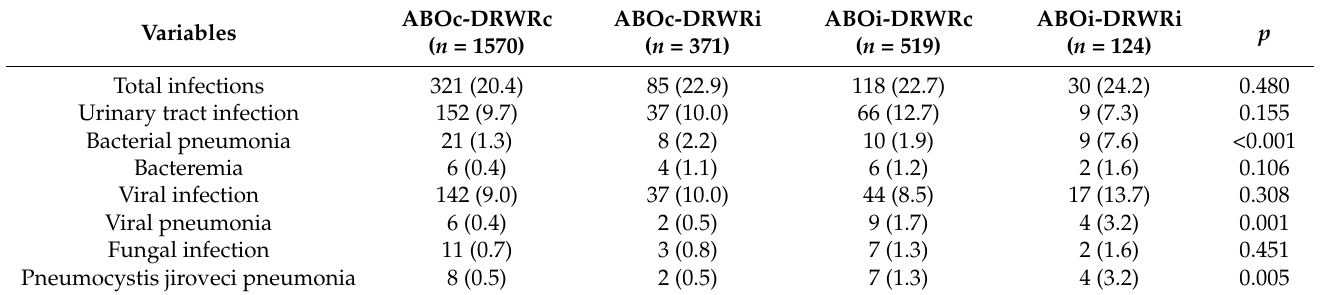
Table 3. Infectious complications within 1 year after kidney